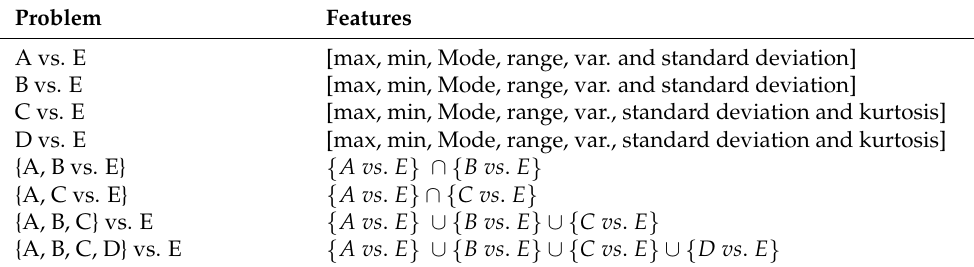
Table 3. Stage 2 of the feature selection process using Mann – Whitney U metric. Table 4. The final features data